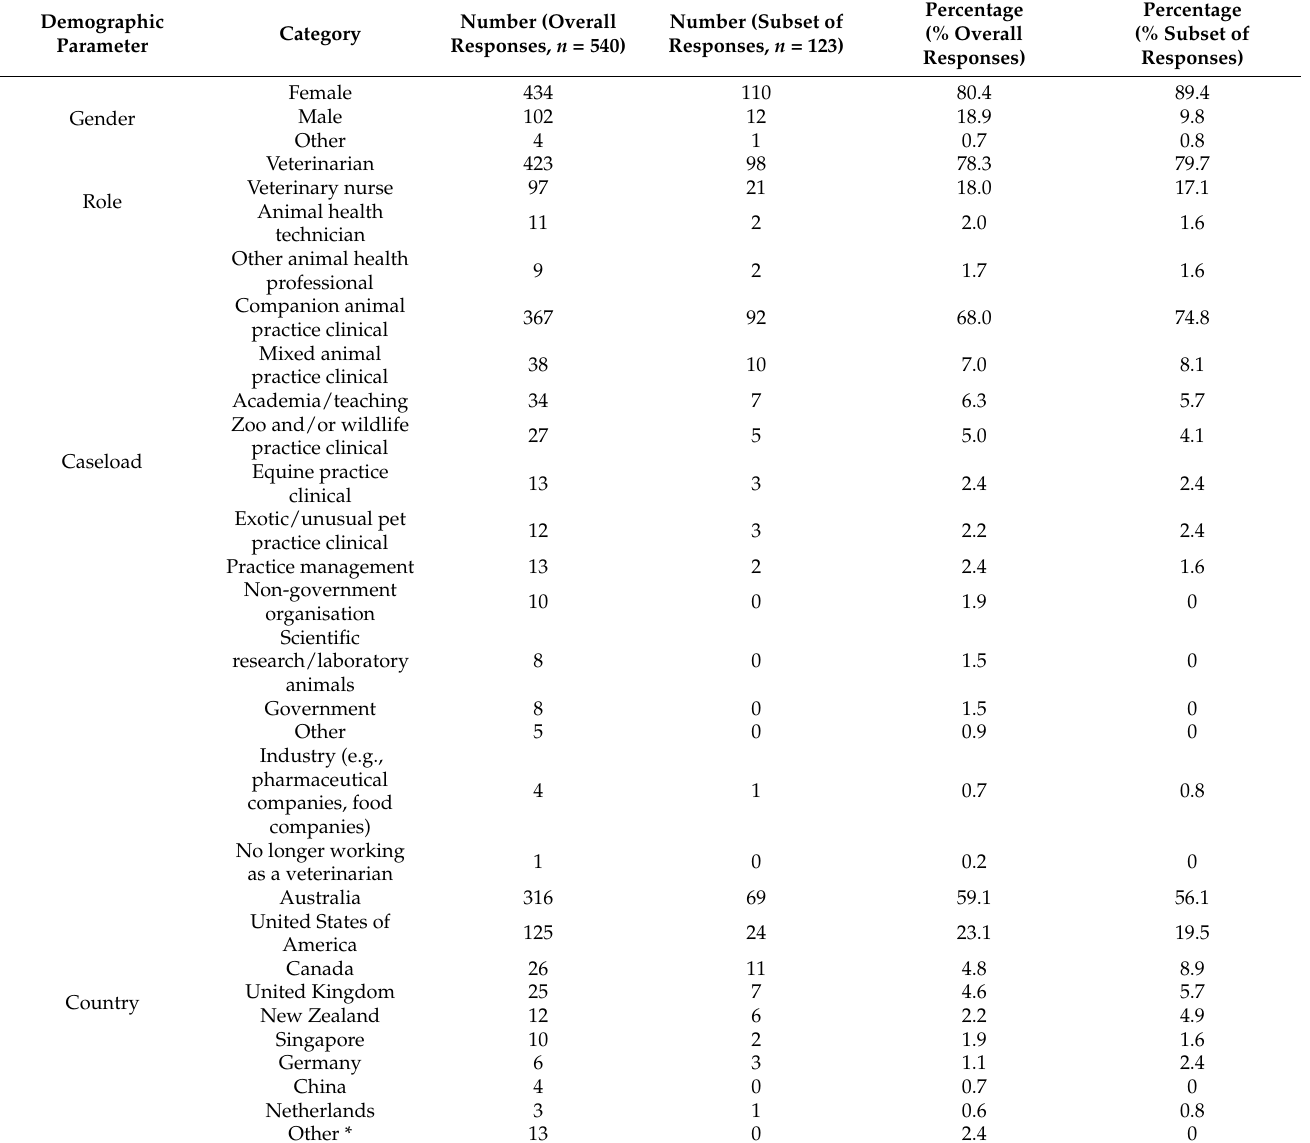
Table 1. Frequency table providing key demographic information for total number of respondents ( n = 540) and a subset of respondents who made commented on low and no-contact euthanasia ( n = 123) in a mixed methods survey on ethically challenging situations encountered by veterinarians, animal health technicians and veterinary nurses globally during the early months of the COVID-19 pandemic in